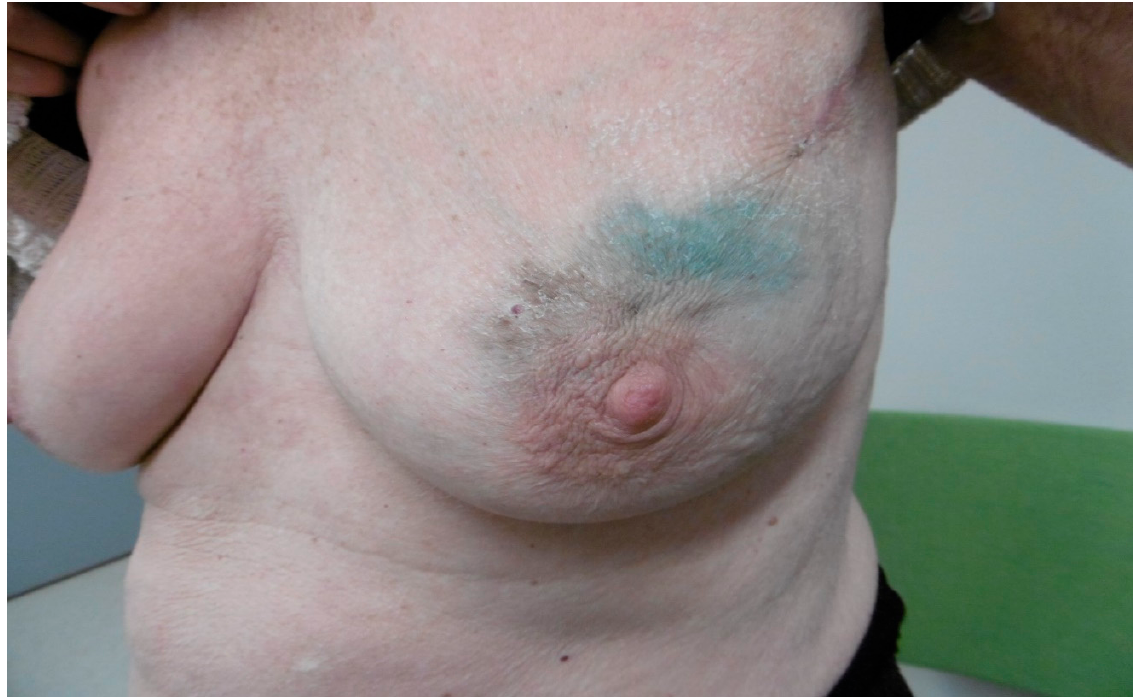
Figure 1. Illustrates a woman 6 months postoperative who received both SPIO and BD. The blue color represents BD staining. The brown color represents SPIO staining.